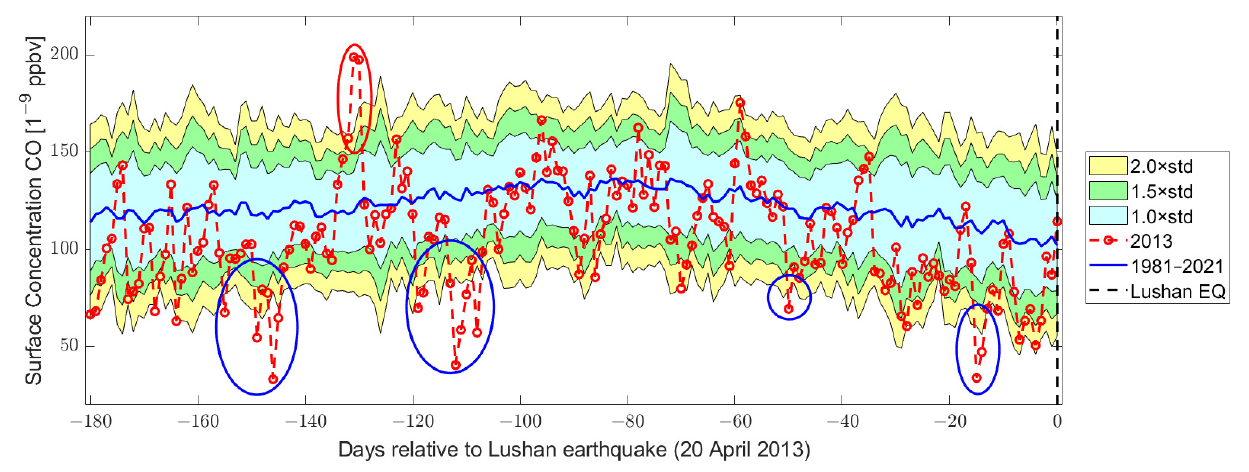
Figure 12. Carbon monoxide levels from the six months before the Mw 6.7 Lushan 2013